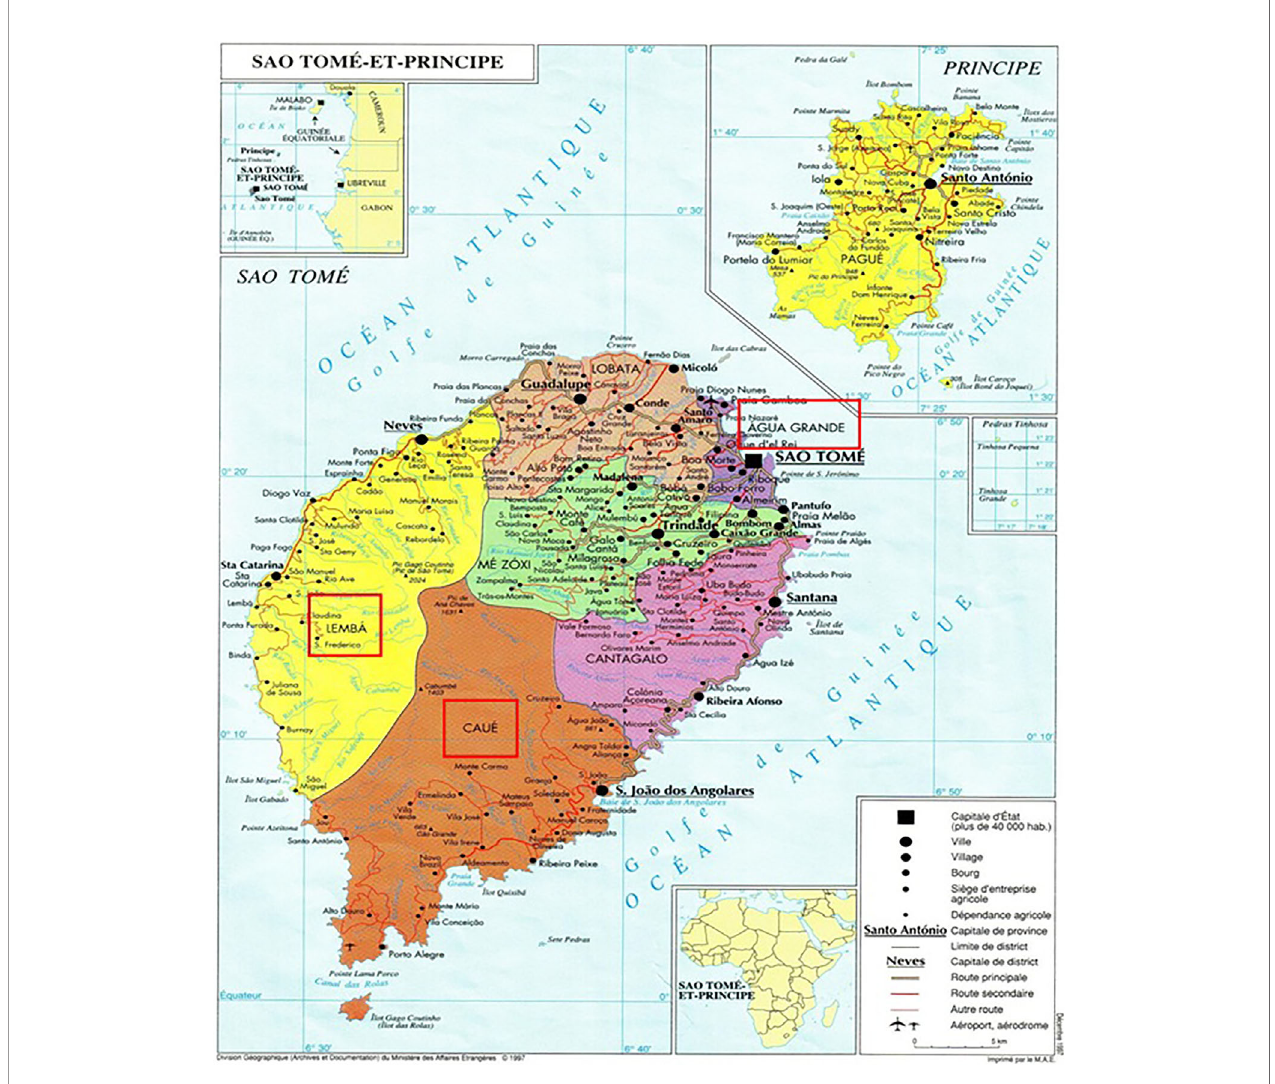
FIGURE 1 | The map of São Tome ́ and Pr ı ́